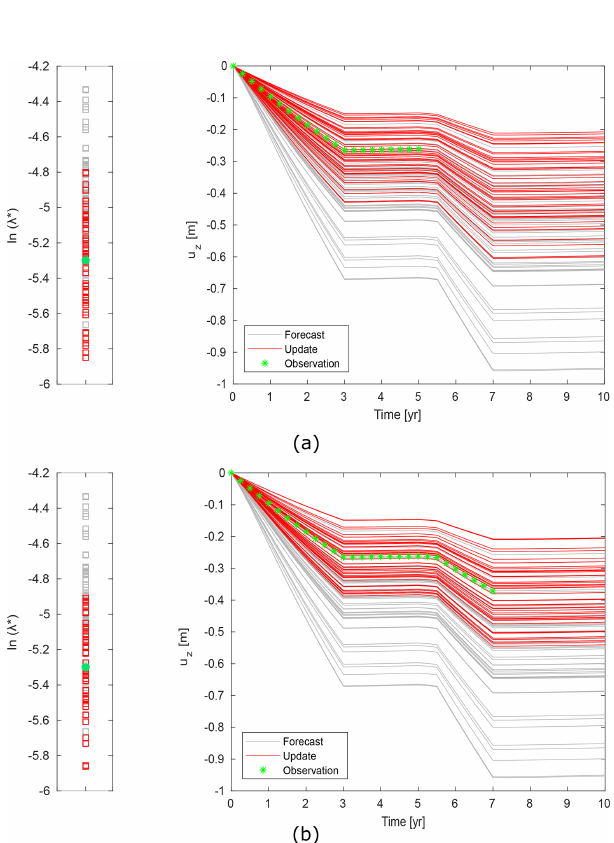
Figure 2. The same as in Fig. 1 for set #1 for the assimilation of 5 years (a) and 7 years (b) of displacements measurements (green stars).